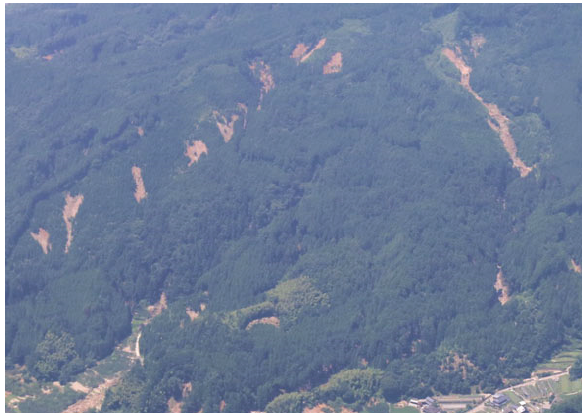
Figure 18. Sediment disasters in Hita City (1).